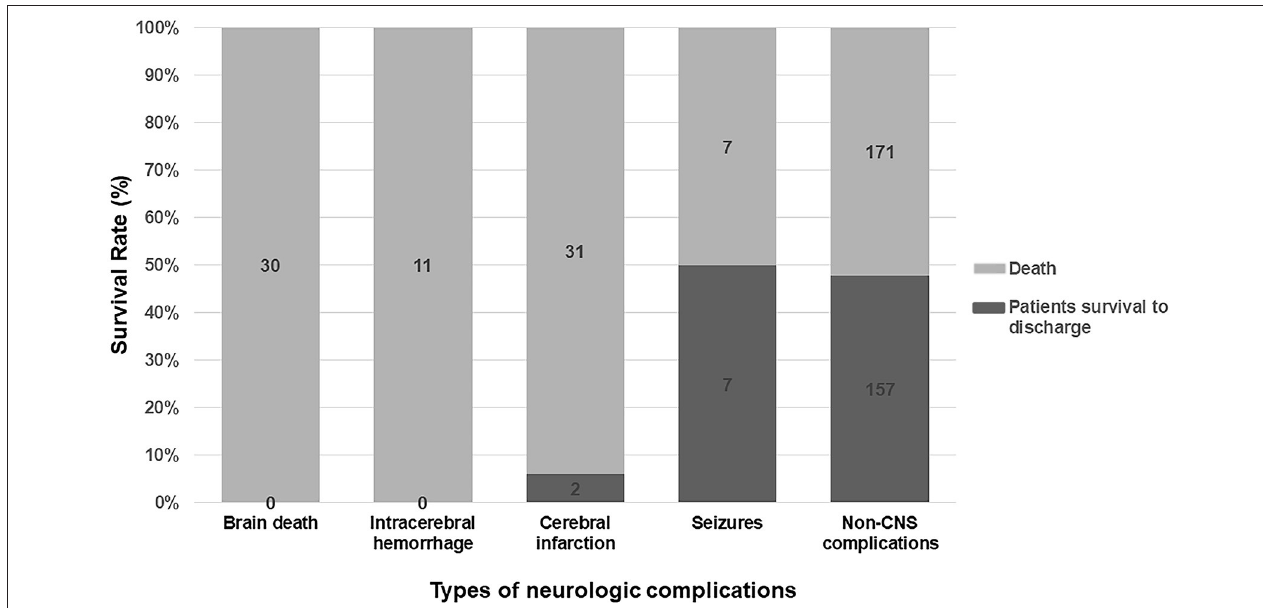
FIGURE 4 | Subgroup analysis for survival rate in different kinds of neurologic complications. Patients with brain death, intracranial hemorrhage, and cerebral infarction had a catastrophic outcome. Patients suffered seizures had a similar prognosis to patients in the control